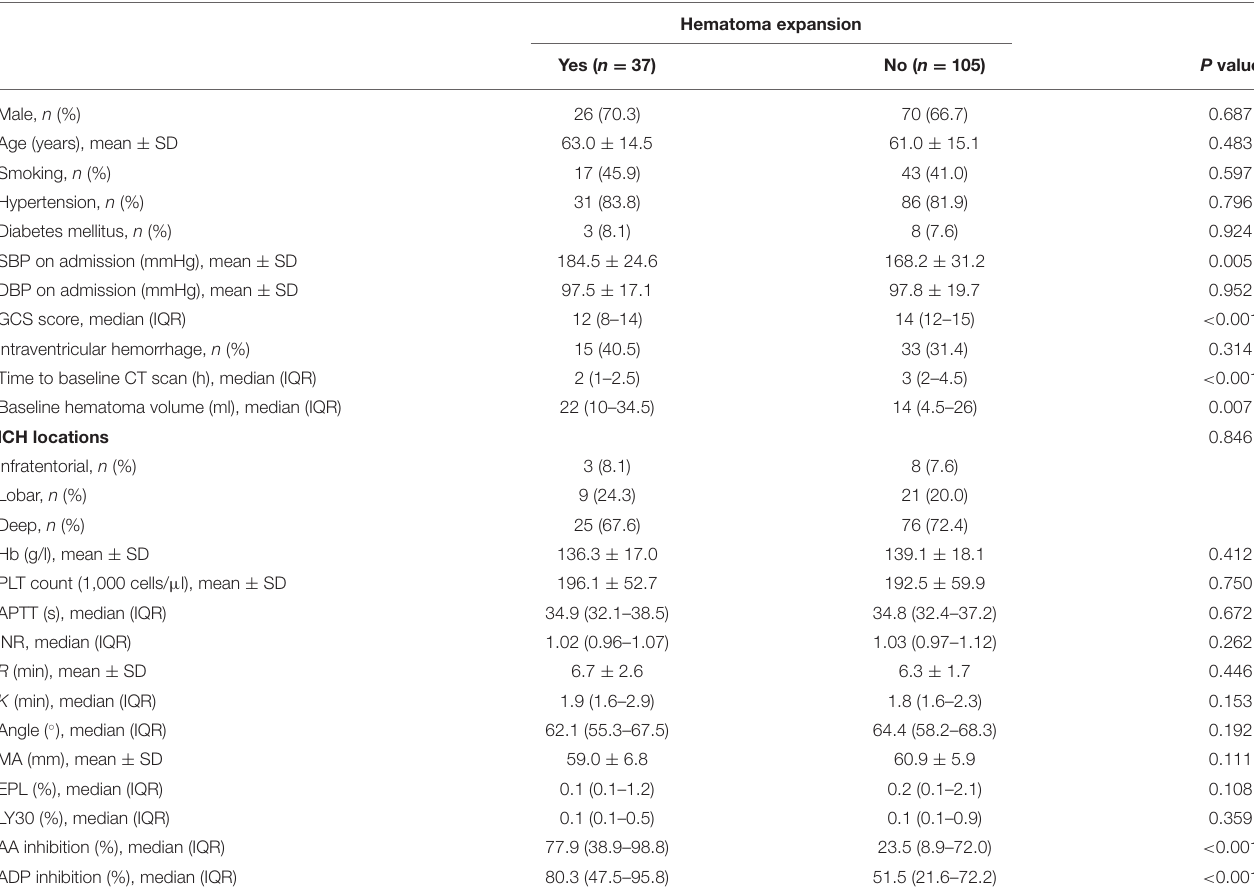
TABLE 1 | Comparison of baseline demographic, clinical characteristics, and TEG-PM parameters between patients with and without hematoma